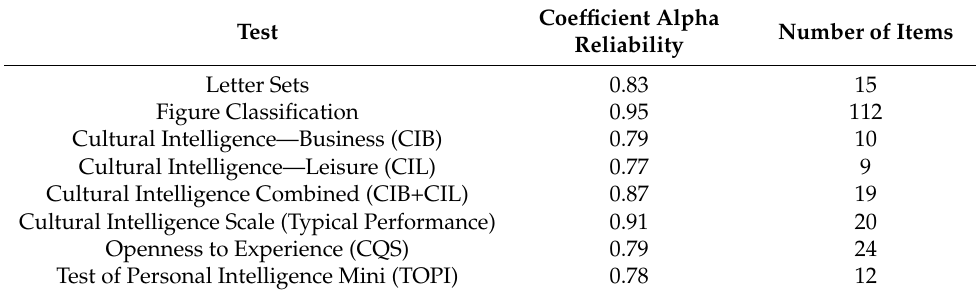
Table 3. Internal-Consistency Reliabilities (Coefficient